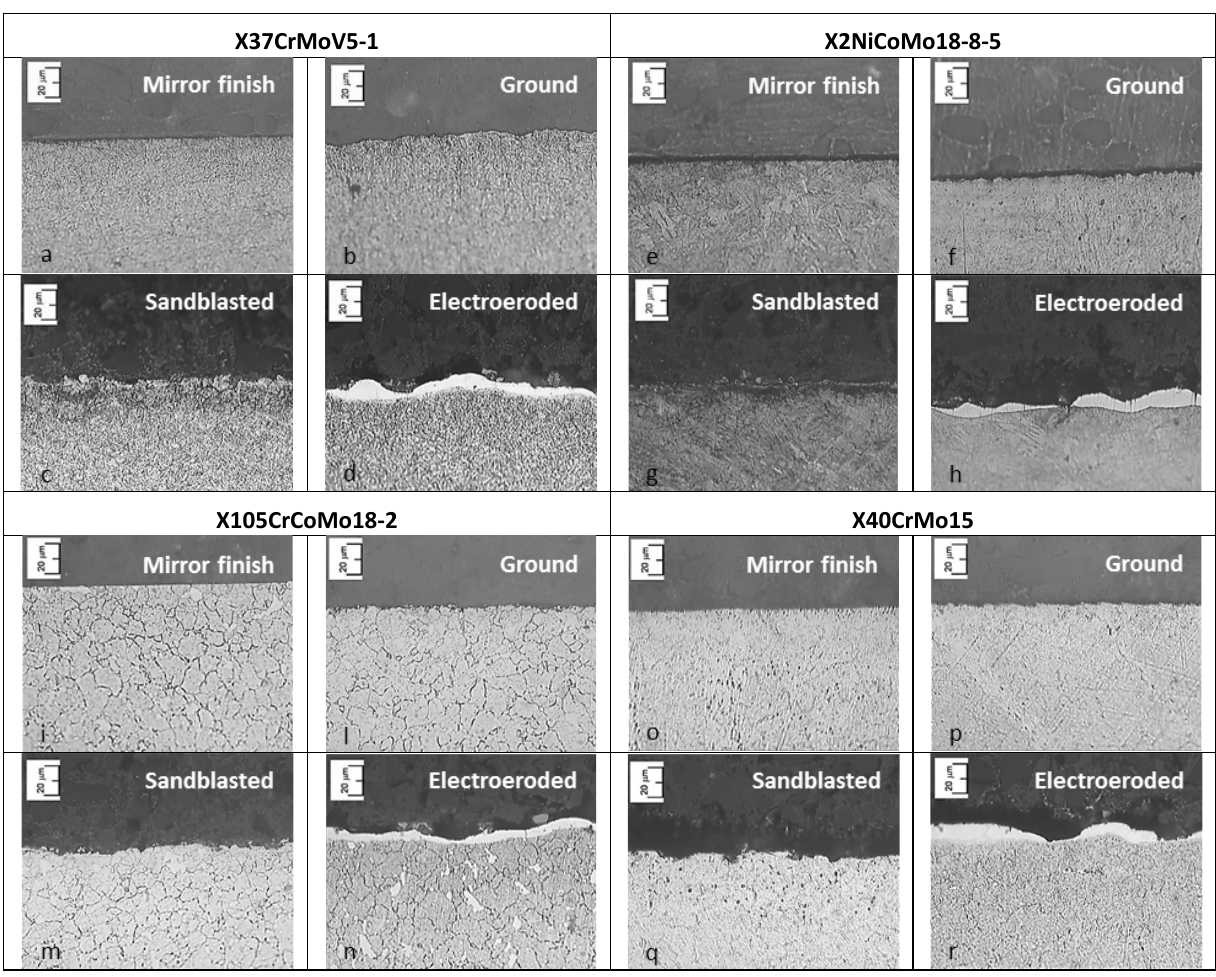
Figure 1. Metallographic sections cut from different surfaces of the bare steels under analysis.